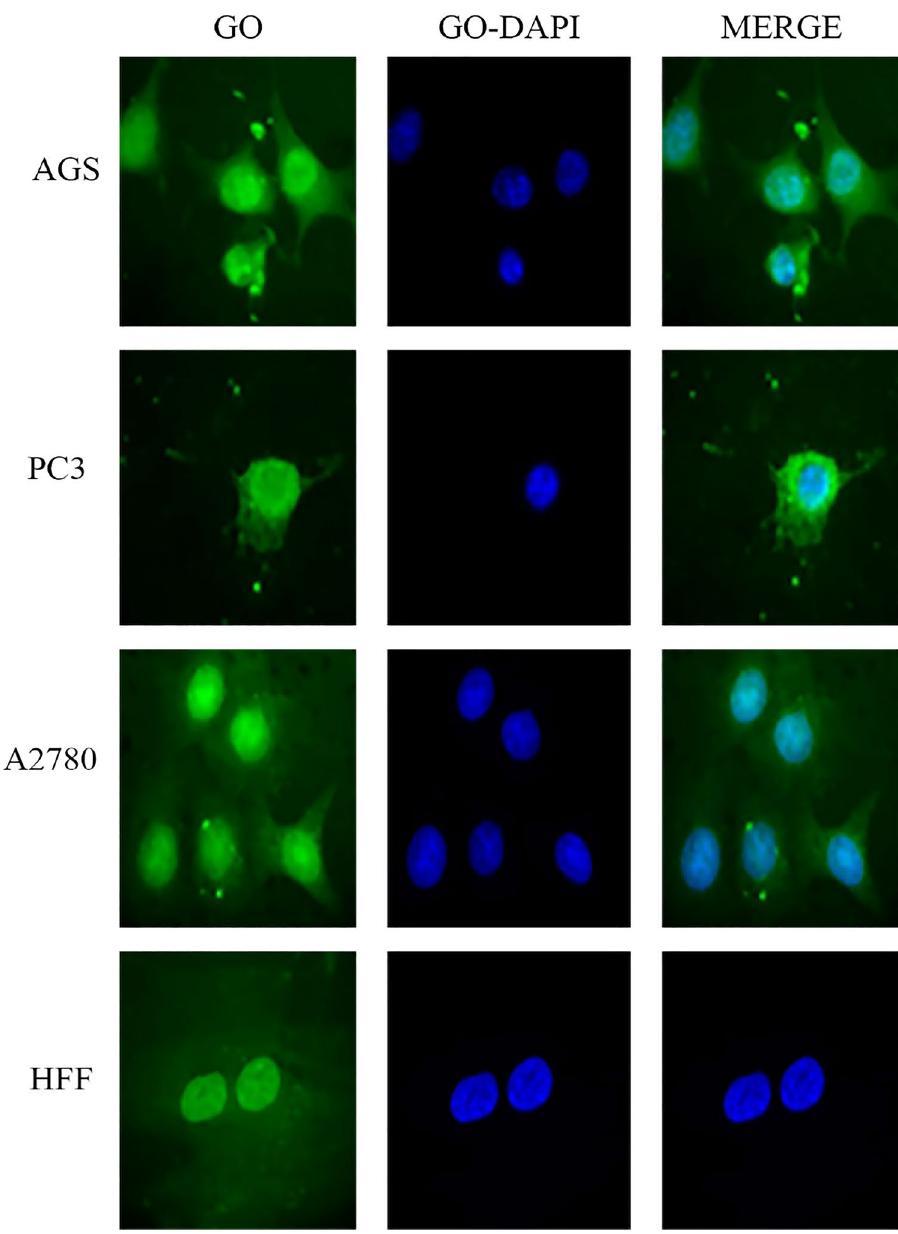
Figure 6. Cellular uptake images of AGS, PC3, A2780 and HFF cells incubated with GO-DIL for 180